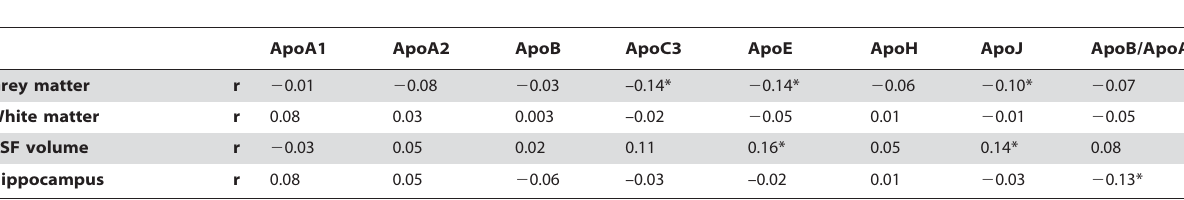
Table 5. Partial correlation between apolipoprotein levels and brain volumes at Wave 1.